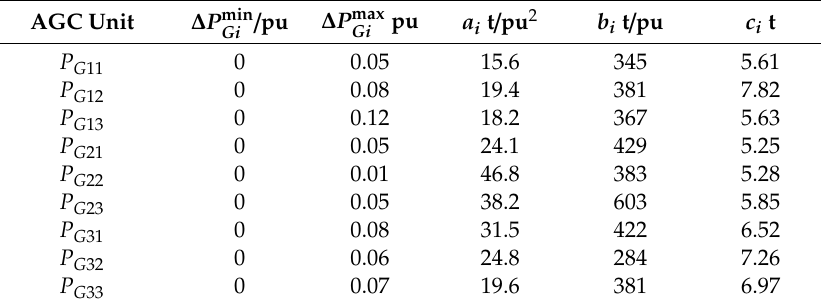
Table 3. Coal consumption coe ffi cients of AGC